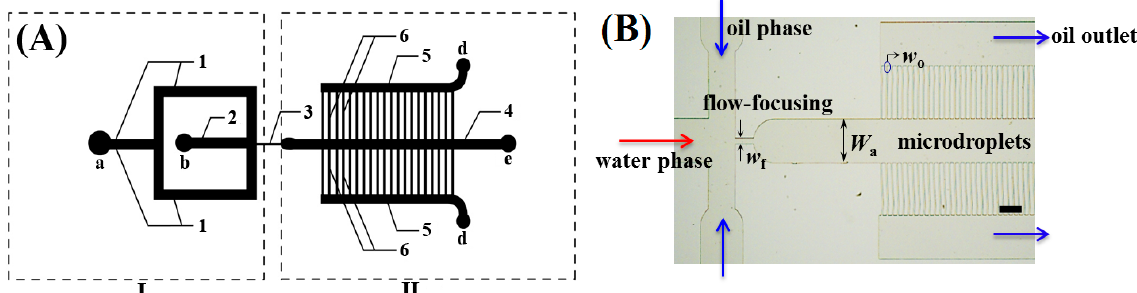
Figure 1. ( A ) Schematic drawing of the flow-focusing microfluidic device with sections